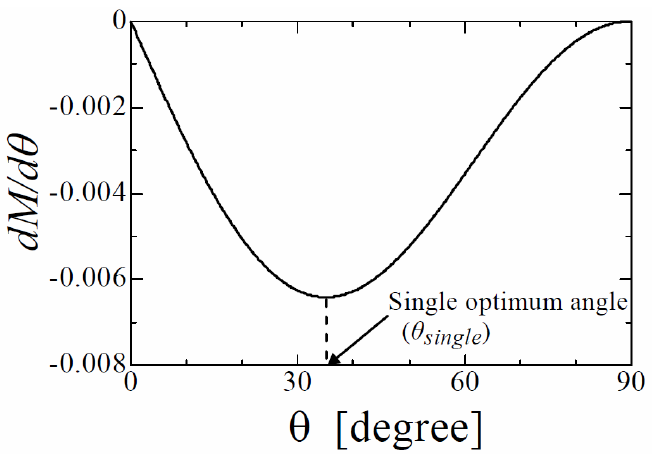
Fig. 14 Relationship between θ and dM / d θ